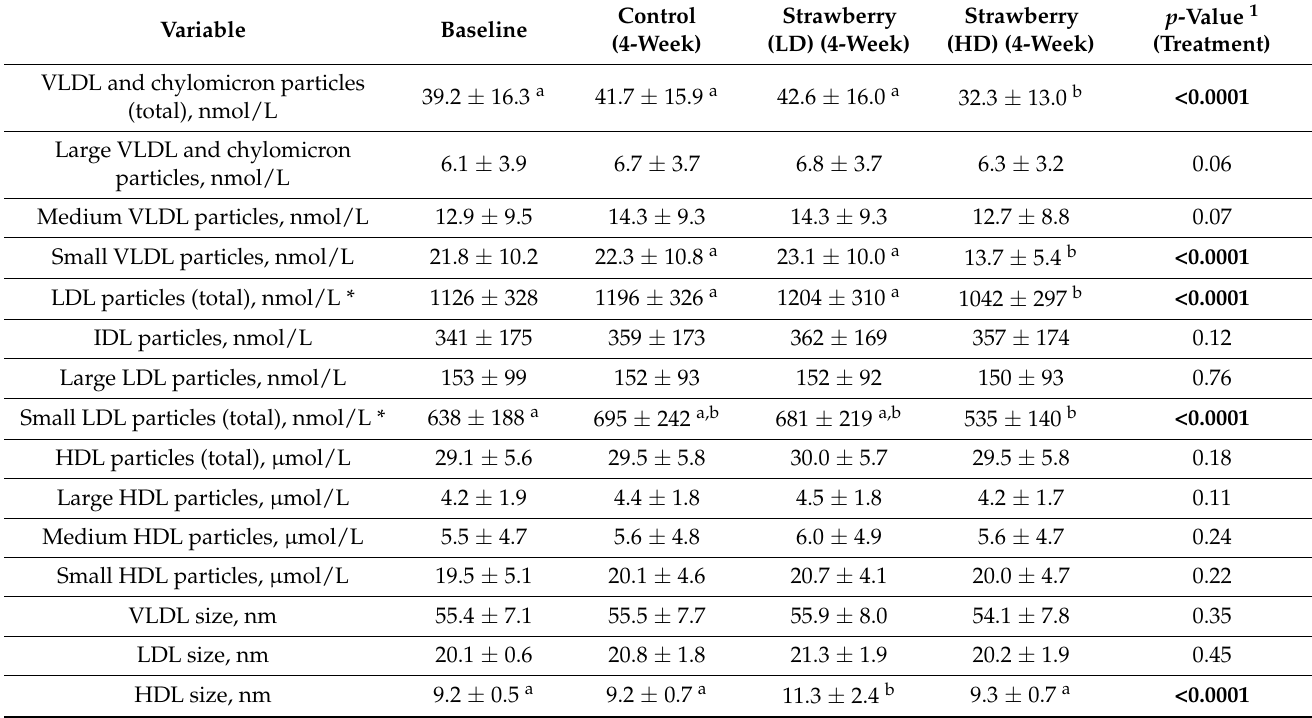
Table 4. Plasma NMR-derived lipid particle concentrations and size in obese adults with above optimal serum LDL cholesterol following each treatment period in a randomized crossover